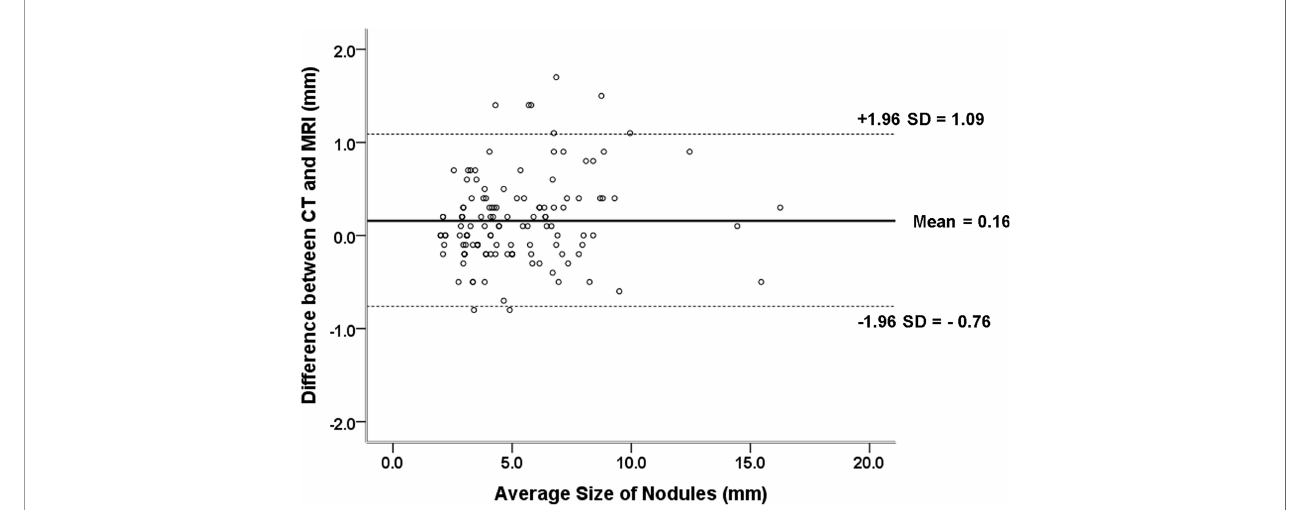
FIGURE 3 | Difference between pulmonary nodule size measurements on CT and MRI against the mean measurement with 95% limits of agreement (mean difference between CT and MRI measurements, 0.16 mm; 95% limits of agreement, – 0.76 mm and 1.09